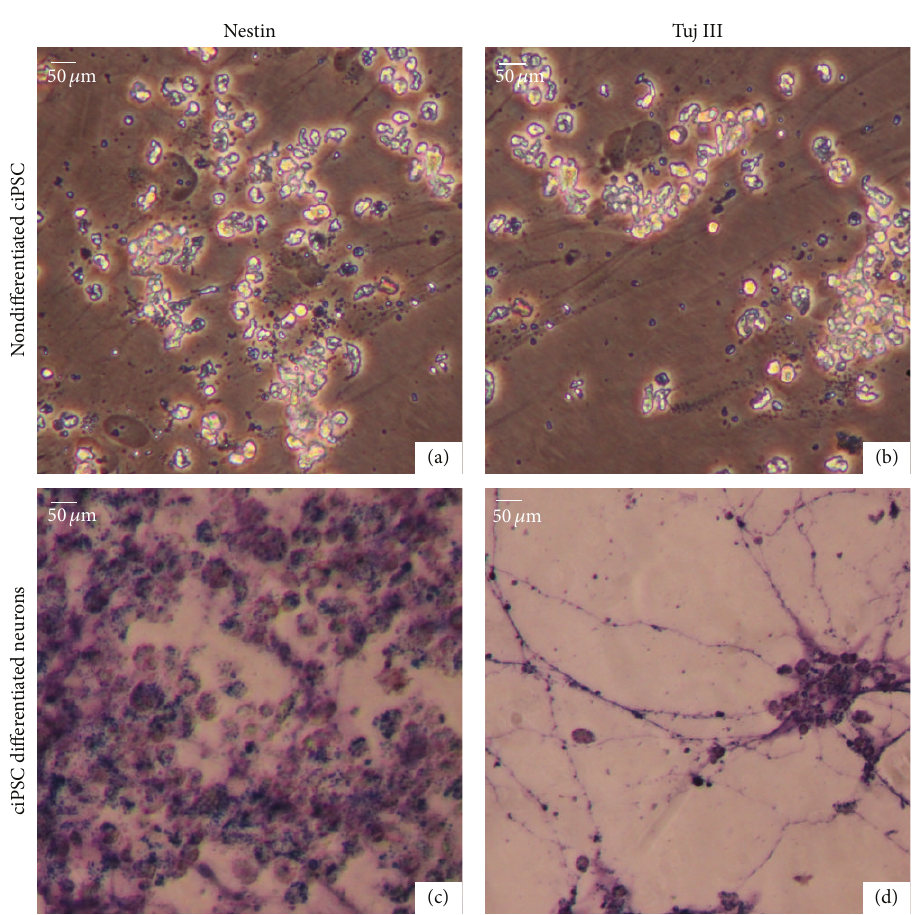
Figure 7: Neural marker staining of more fully differentiated neurons. (a) and (b) Nestin and beta-tubulin III (TU-20) labeling of nondifferentiated chicken iPSC-like cells. iPSC-like cells have shiny appearance under the light settings used. (c) and (d) Differentiated neurons from chicken iPSC-like cells stained positive for Nestin and beta-tubulin III at day 14 (purple label).